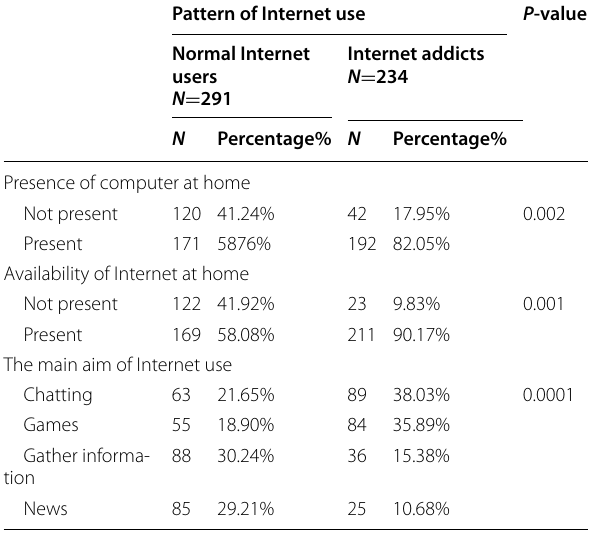
Table 2 Association between Internet addiction and patterns of Internet use